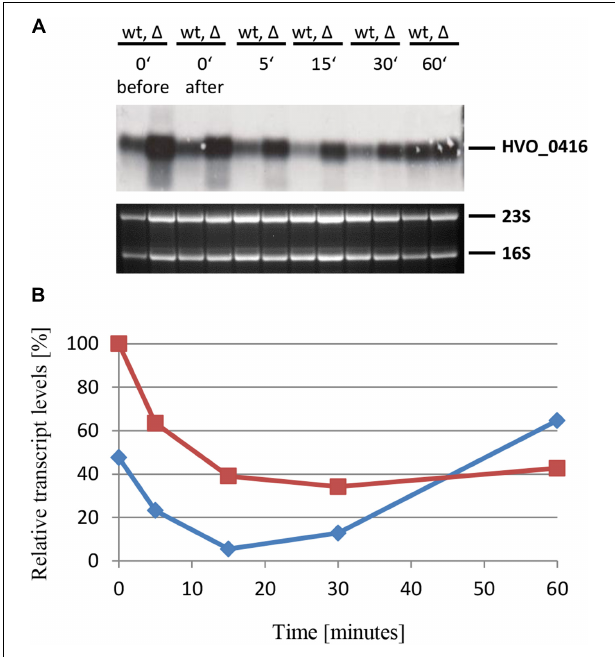
FIGURE 10 | Kinetic analysis of the HVO_0416 mRNA level after the onset of phosphate starvation. (A) HVO_0416 encodes a small CPXCG zinc finger protein. The wild-type (wt) H26 and the sRNA132 gene deletion mutant ( (cid:49) ) were grown to mid-exponential growth phase in the presence of phosphate (1 mM). The cells were harvested and resuspended in phosphate-free medium. At the time points indicated at the top aliquots were removed, RNA was isolated and used for Northern blot analysis with an HVO_0416-specific probe. Ethidium bromide stained 23S and 16S rRNAs are shown at the bottom. (B) The signals of the Northern blots were quantified densitometrically, and the kinetic changes of relative transcript levels are